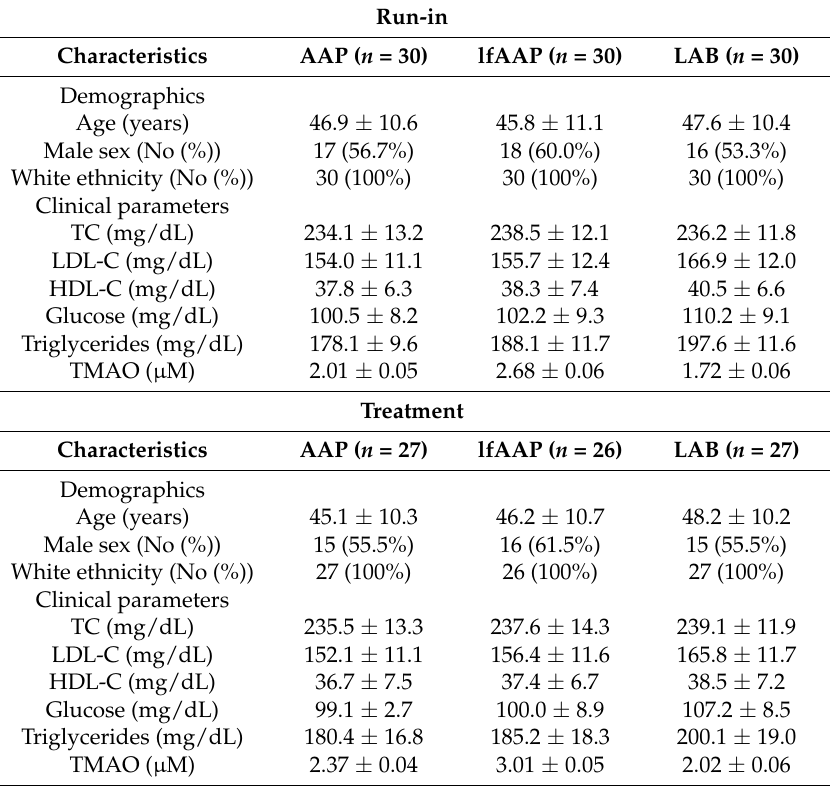
Table 2. Baseline characteristics of intention to treat sample according to study